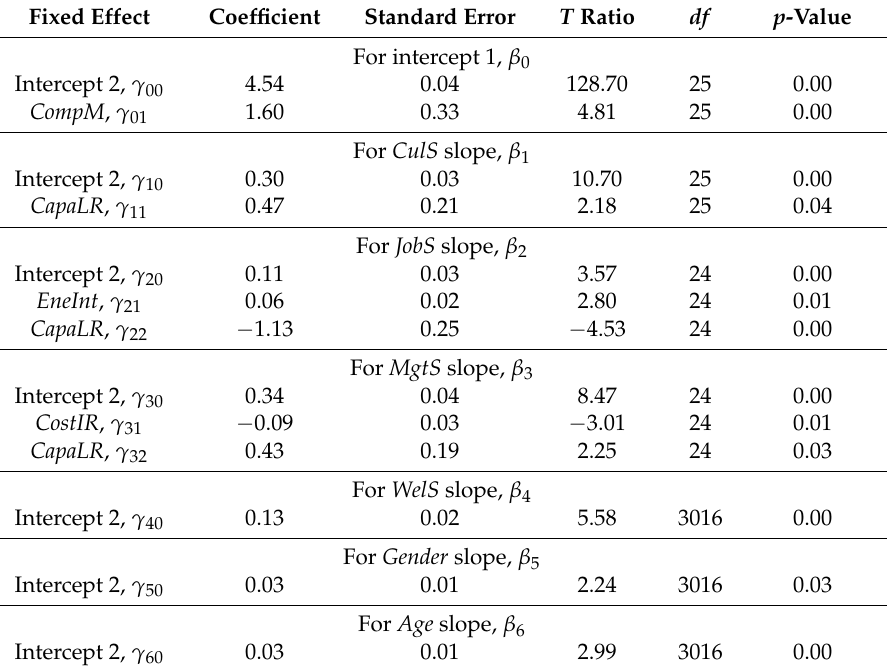
Table 3. Final estimation of fixed effects in the model with fixed and random effects.